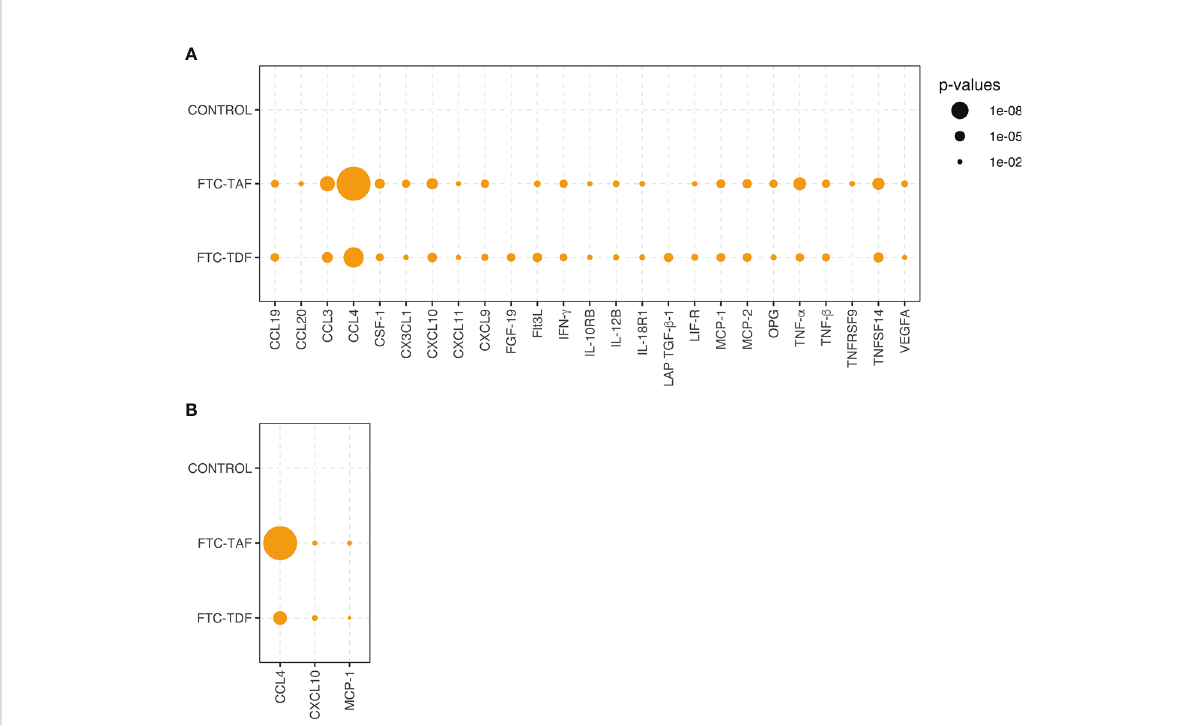
FIGURE 2 Statistical signi fi cance of in fl ammatory protein comparison between paired pre- and post-PrEP plasma samples. Statistical signi fi cance of comparative abundance values of all proteins detected in Olink (n=26) between pre- and post-PrEP samples from the two PrEP groups (FCT- TAF and FTC-TDF) are shown in (A) and for Luminex (n=3) in (B) . Proteins which yielded a statistically signi fi cant difference (p < 0.01) are represented by circles whose size re fl ects the level of signi fi